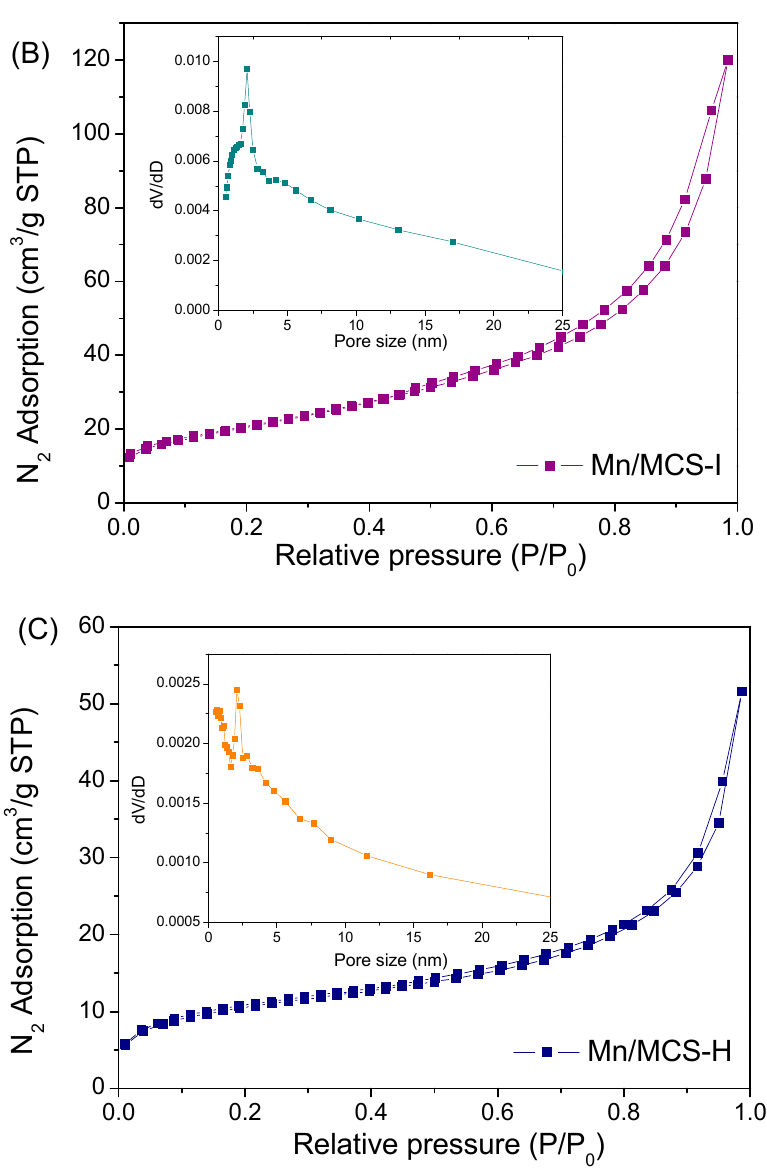
Figure 4. Nitrogen sorption isotherms and pore size distributions for Mn/MCS ‐ R ( A ); Mn/MCS ‐ I ( B ); Mn/MCS ‐ H ( C ). Table 1. Physicochemical properties of Fe 3 O 4 /C/Mn hybrids and their activities in phenol degradation.